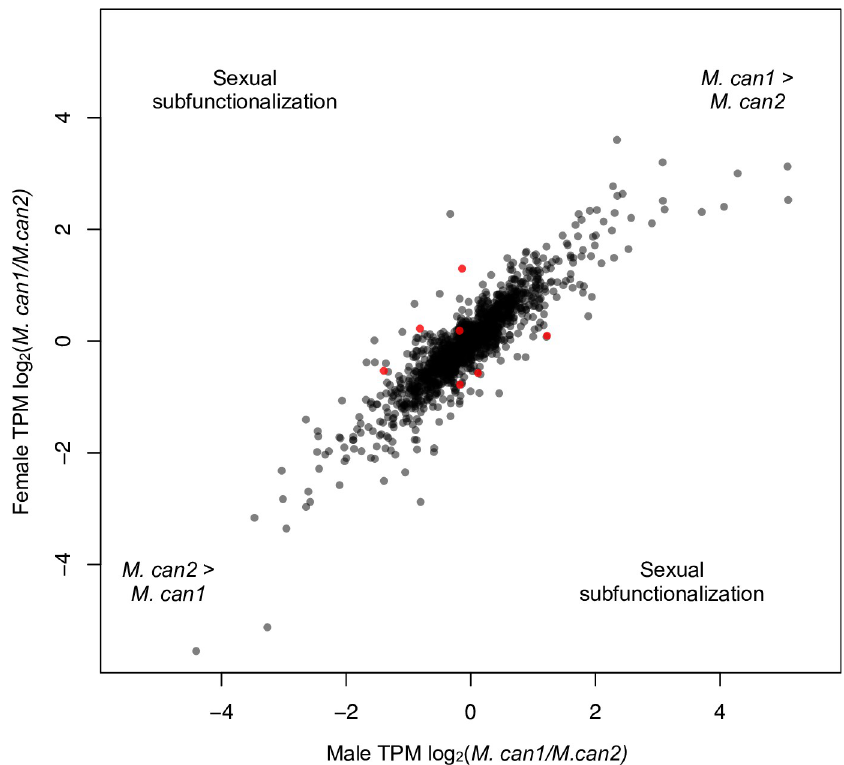
Fig 4. Potential subfunctionalization of M . can1 and M . can2 subgenomes. Expression is shown in TPM (transcripts per million). Several homeolog pairs are subfunctionalized (expressed higher in one subgenome). Seven pairs of homeologs showed evidence of sexual subfunctionalization (shown in